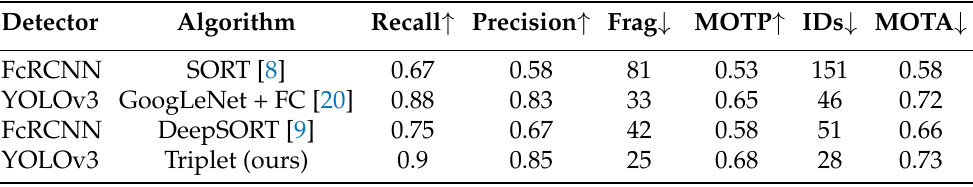
Table 1. Comparison of the proposed method with other models. The arrows indicate better performance for each metric. (i.e., down arrow—lower is better).